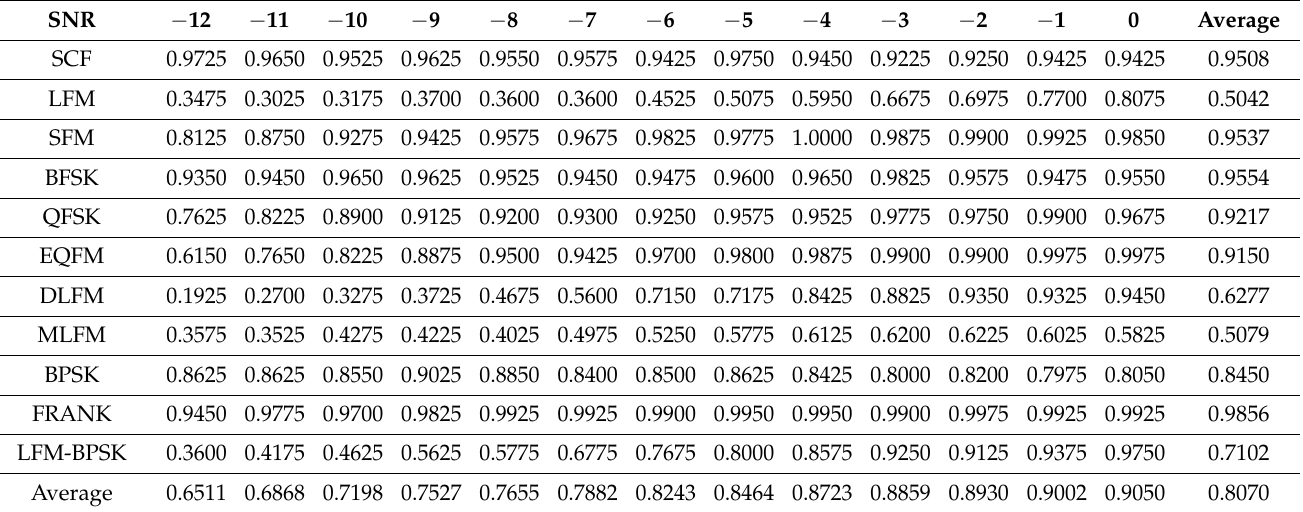
Table A20. Semi-supervised classification results with the datasets in Situation Dataset 4 ( d = 1 constant).